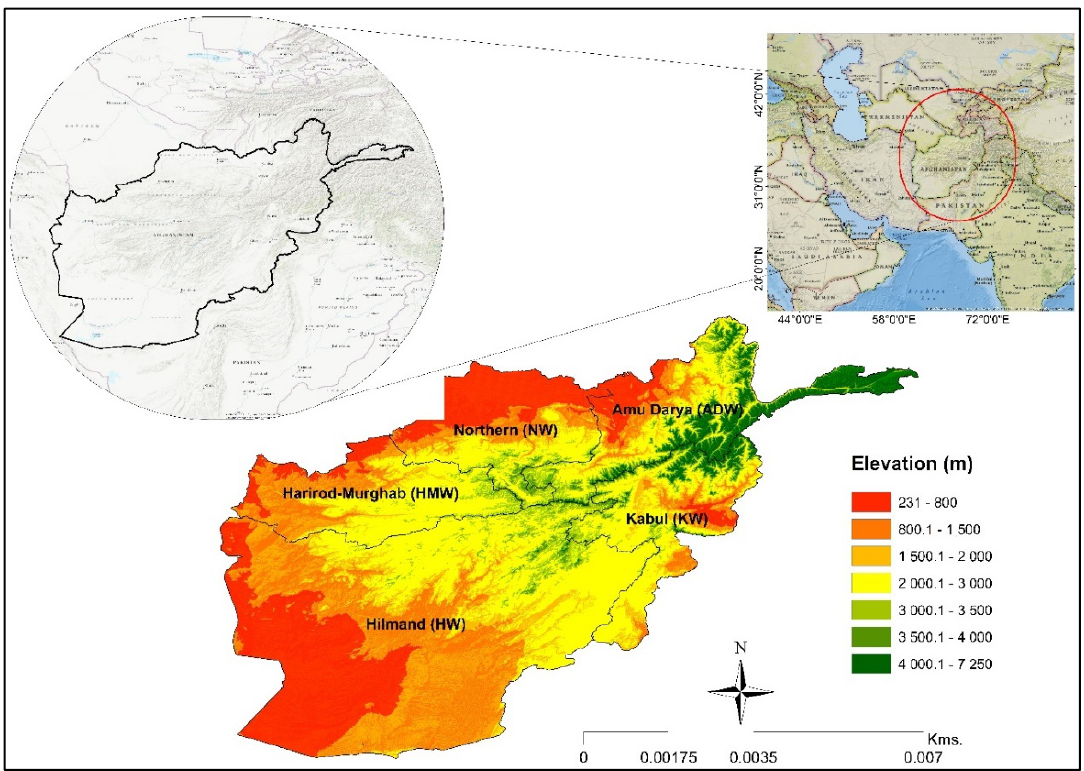
Figure 1. Elevation and the main watersheds of the study area, Afghanistan.